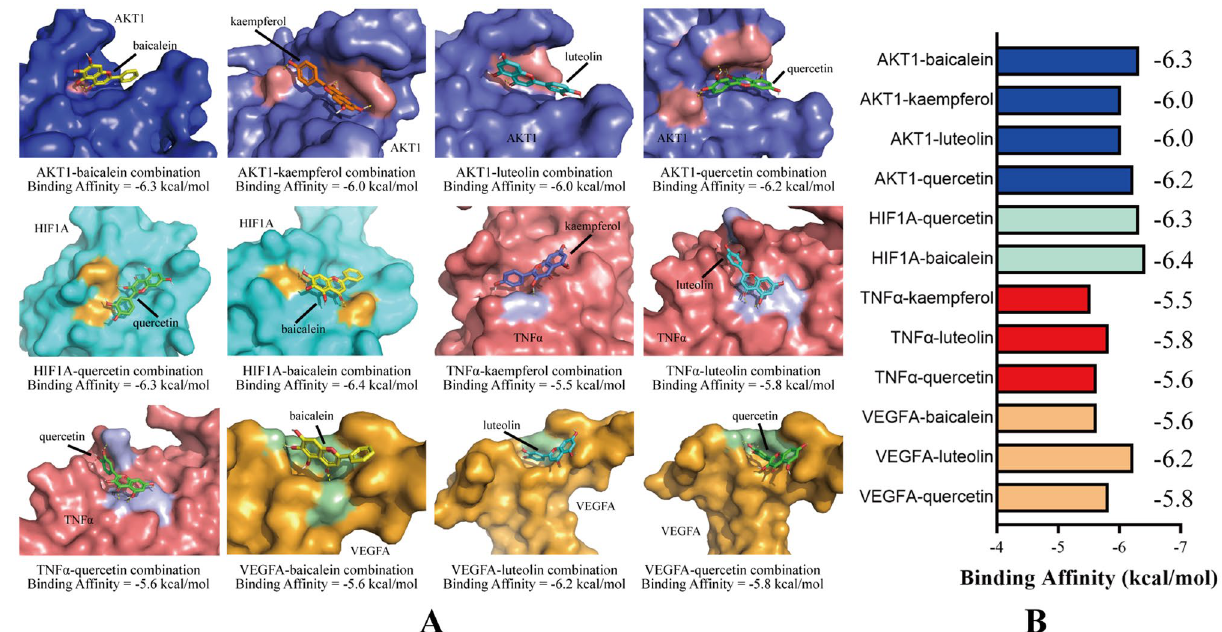
Figure 5. Molecular docking results. ( A ) Docking patterns of key targets (AKT1, HIF1A, TNFα, and VEGFA) and specific active ingredients (baicalein, kaempferol, quercetin, and luteolin) of herbs. ( B ) Binding affinities (kcal/mol) of key targets and specific active ingredients of